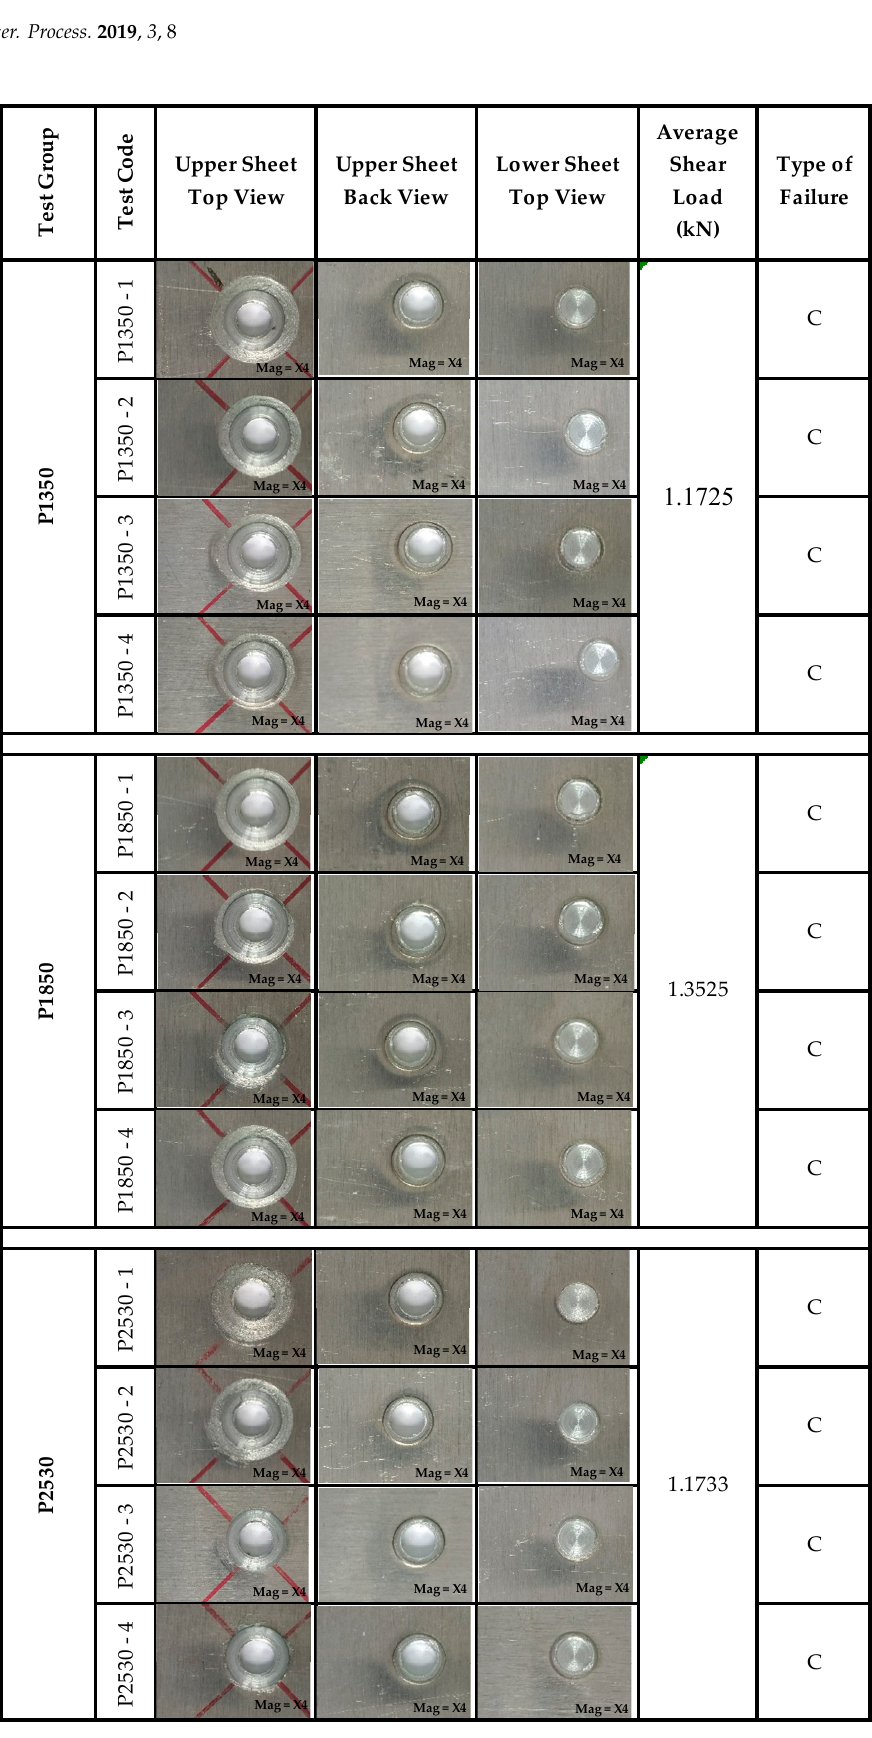
Figure 9. Failure modes of broken test samples. (C: Mode 3; nugget pullout failure).